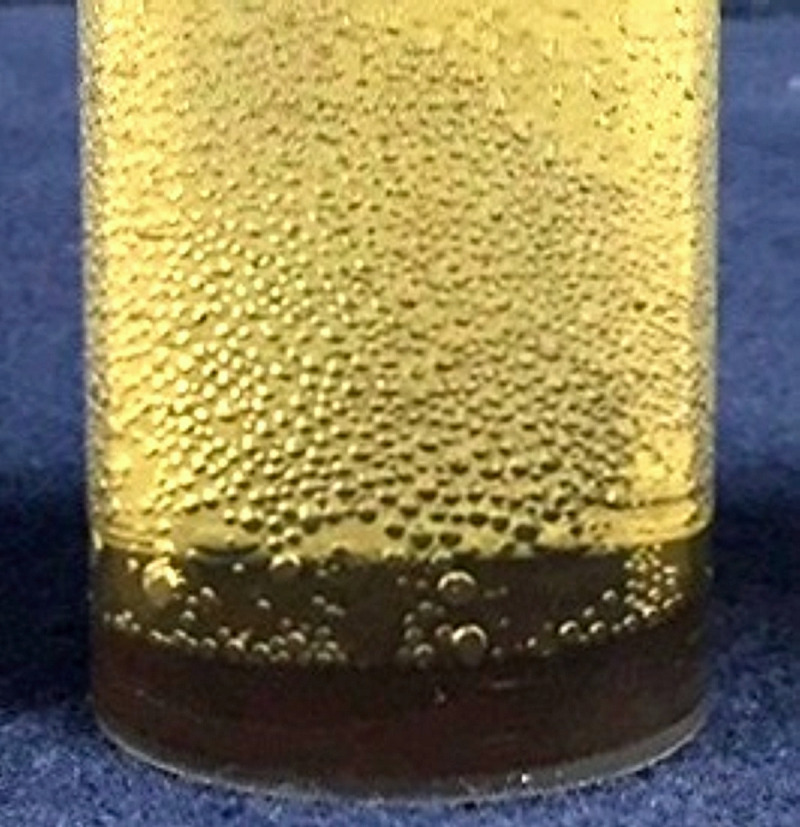
Example of gas generation.Bi2O3 in NaOCl after 24 h, Light.